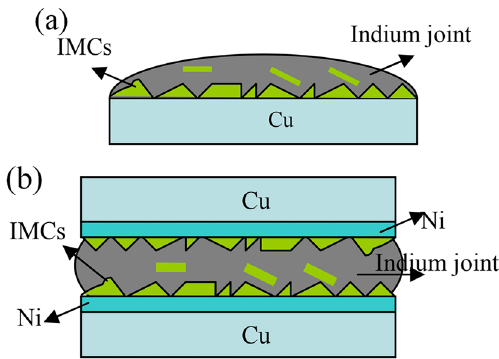
Figure 12 Specimen configurations and thermal cycle temperature profile [62]: ( a) Single chip indium joint, ( b) Sandwich type